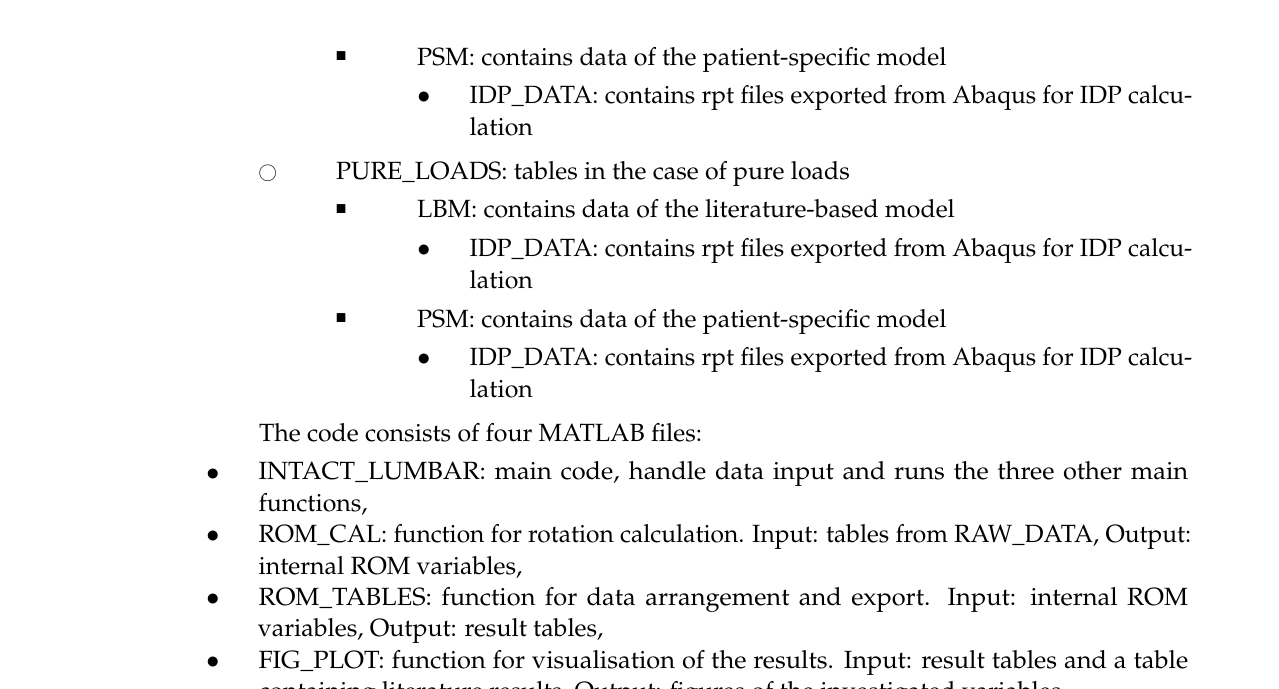
FIG_PLOT: function for visualisation of the results. Input: result tables and a table containing literature results, Output: figures of the investigated variables.